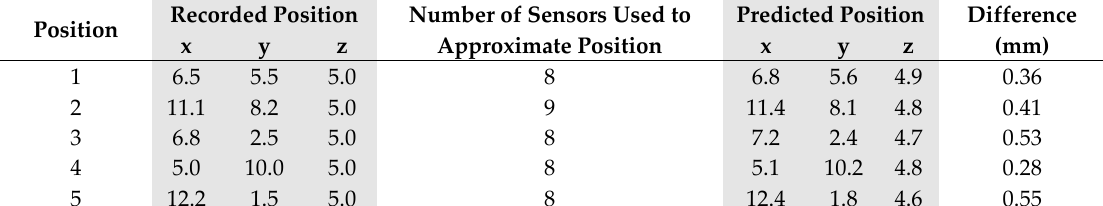
Figure 7. ( a ) Difference in recorded magnet position and predicated magnet position at increasing z distance when positioned directly above a single sensor. ( b ) Mean difference and standard deviation in x-y magnet position using a varying number of sensors to predict magnet position when held at 5 mm vertical distance from the sensor board. Table 2. Recorded magnet position against the predicted magnet position at five controlled spatial